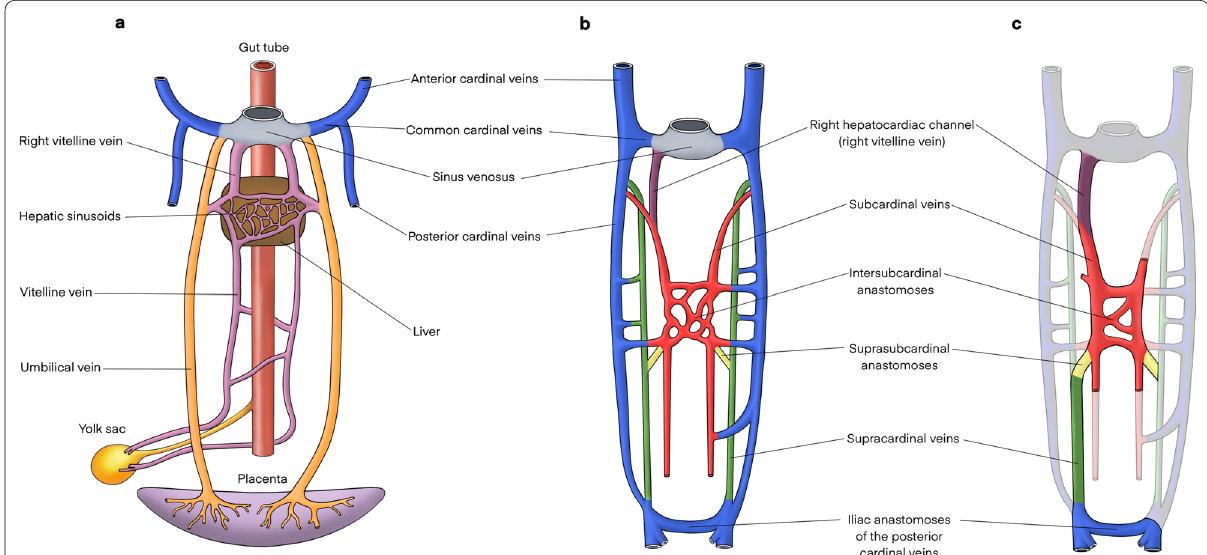
Fig. 1 Embryological development of the IVC. a The sinus venosus receives paired common cardinal, umbilical and vitelline veins draining blood from general tissue, the placenta and the yolk sac, respectively. b The right hepatocardiac channel (purple) is formed by the right vitelline vein and persists to become the hepatic IVC. Paired subcardinal (red) and supracardinal veins (green) emerge and form multiple anastomotic channels. These include the intersubcardinal anastomoses, suprasubcardinal anastomoses and fusion between the right subcardinal vein (red) and developing hepatic IVC (purple). As the embryo matures, some of these anastomoses regress. c This illustration highlights vessels that persist to form the mature IVC and its